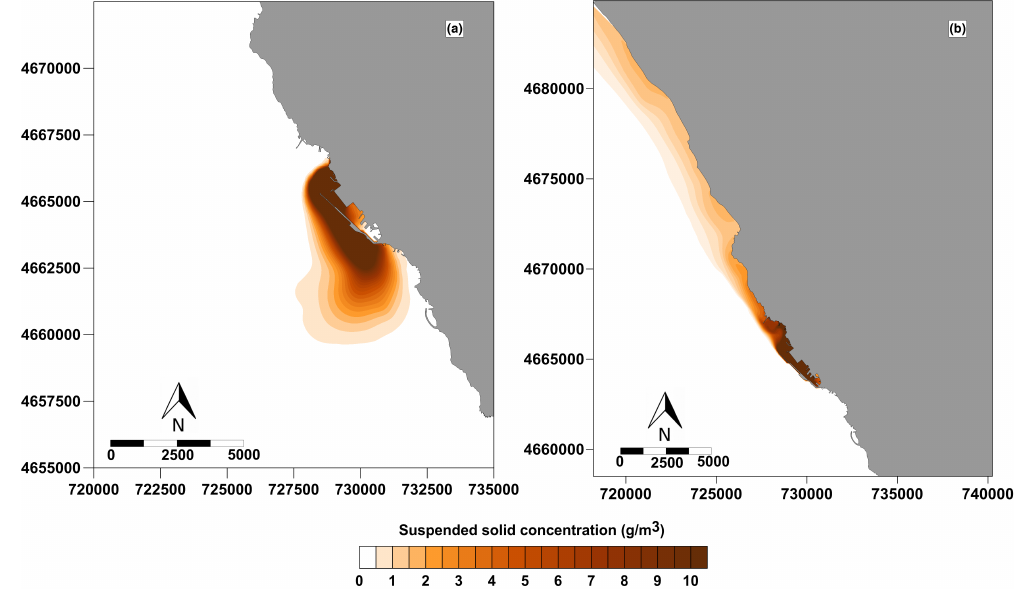
Figure 6. LC (a) and HC (b) simulation results of the dispersion of dredged materials in the study area. The distribution of fine sediment concentration refers to the end of the simulation